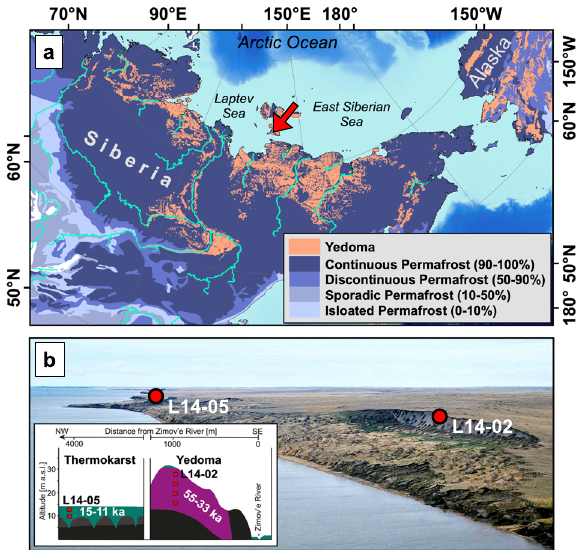
Fig. 1 | Location of the study site in Arctic Siberia. a includes an overview map withthe studysiteindicated bythe red arrow, thedistributionof Yedomadeposits shown in orange color 69,70 , and the different permafrost zones as blue shades 71 . b shows an aerial overview photograph of Bol ’ shoy Lyakhovsky Island where red markersindicatethelocationsofthepermafrostdrillcoresL14-02andL14-05.Also shown is the local stratigraphy with positions of the six samples of a Yedoma hill (L14-02)andathermokarstbasin(L14-05)markedinred.Dataforbathymetricbase map of panel a based on IBCAO 72 ; photograph in panel b by G. Schwamborn was previouslypublishedbyZimmermann,H.etal.TheHistoryofTreeandShrubTaxa on Bol ’ shoy Lyakhovsky Island (New Siberian Archipelago) since the Last Inter- glacial Uncovered by Sedimentary Ancient DNA and Pollen Data. Genes (Basel) 8, 273